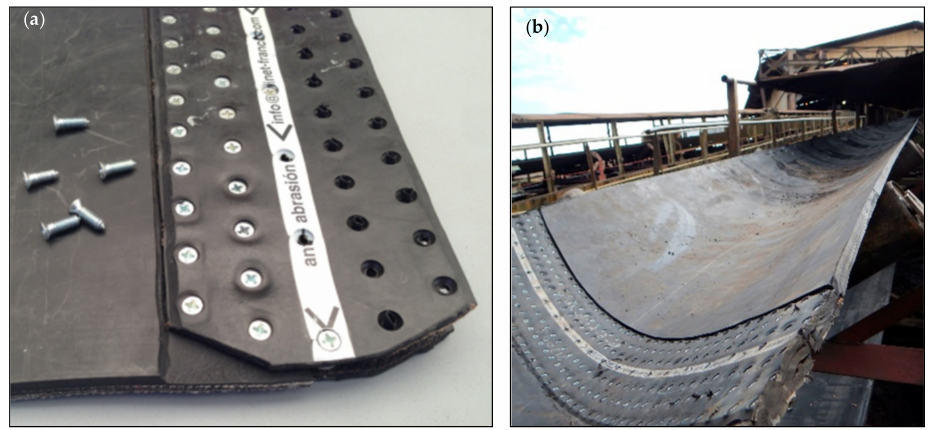
Figure 24. Screws rubber splice fastening: ( a ) one end of the belt attached, ( b ) suitable for trough systems of rollers of a belt conveyor